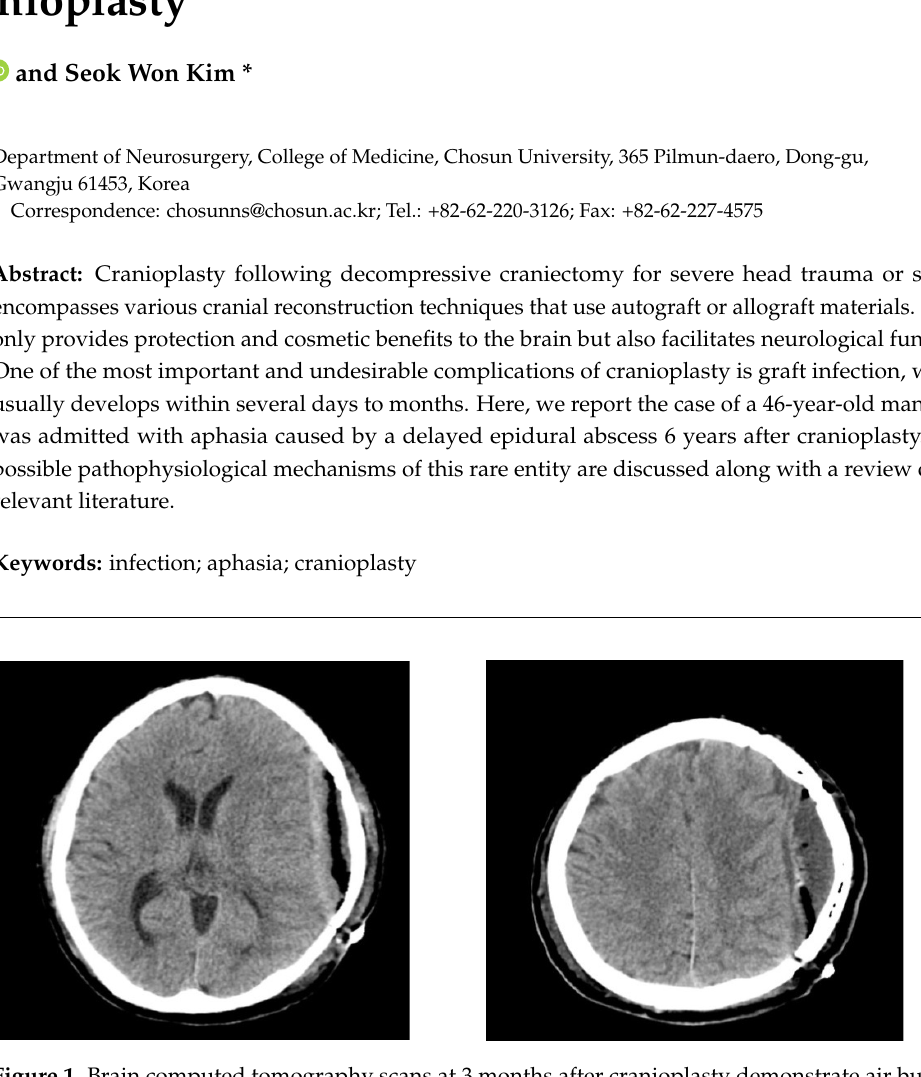
tive air bubbles and epidural fluid collection (Figure 1).